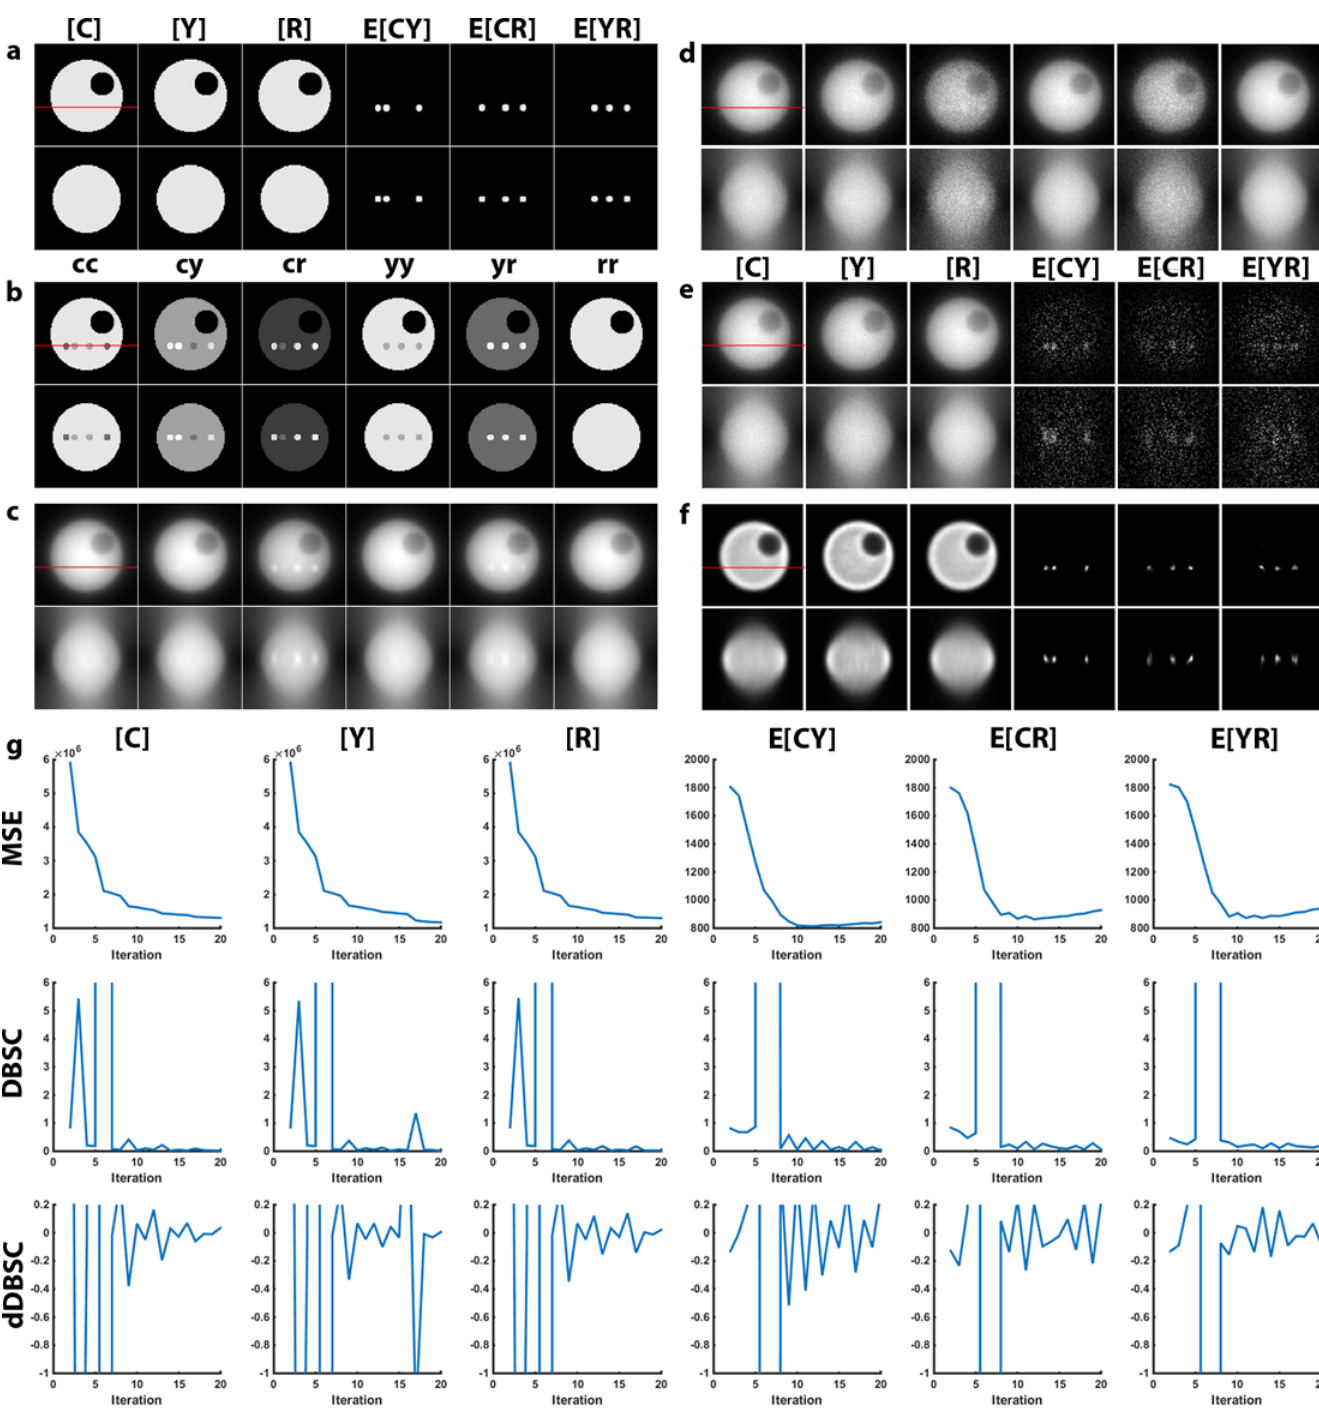
Fig 1. Simulation of 3D-3Way FRET data. (a) A model of a 4.5 μ m diameter cell consisting of localized FRET signal within a large volume of non-FRET signals was created. The top row of images corresponds to the xy midplane of the simulated object, the red line signifies the z-plane used for the xz projection in the bottom row. (b) Spectral mixing of the fluorophore concentrations with matrix B (empirical) gave rise to the fluorescence detected for appropriate excitation/emission combinations (i.e. cc, cy, cr ... ). (c) The fluorescence distributions were blurred with a widefield PSF to account for the imperfect imaging of optical microscopes. (d) Photon noise was simulated by drawing pixel intensities from a Poisson distribution. (e) The data was directly unmixed by N-Way FRET to recover the concentration of total fluorophores and apparent FRET efficiencies, but no improvements in the optical sectioning. (f) The reconstructed estimate was generated following 20 iterations of the modified 3D-3Way FRET algorithm showing improved axial resolution and devoid of false positive artifacts. (g) The MSE, DBSC and dDBSC were calculated at the xy plane shown for each iteration in order to measure convergence. doi:10.1371/journal.pone.0152401.g001 PLOS ONE | DOI:10.1371/journal.pone.0152401 March 29,